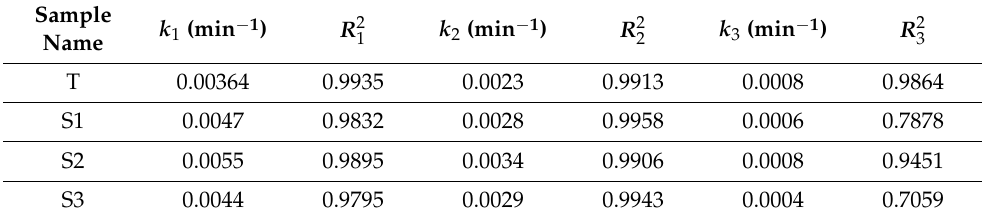
Figure 7. Reaction kinetics of the RhB aqueous solutions in the presence of the T and S1–S3 samples and UV light ( a ). Photocatalytic degradation of RhB solution in the presence of the T and S1–S3 samples ( b ). The reaction rate constant values for each sample ( 𝑘 (cid:2869) , 𝑘 (cid:2870) , and 𝑘 (cid:2871) ) and the corre- sponding linear regression coefficients ( 𝑅 (cid:2869)(cid:2870) , 𝑅 (cid:2870)(cid:2870) , and 𝑅 (cid:2871)(cid:2870) ) are presented in Table 2. Table 2. Reaction kinetics constants of the RhB aqueous solutions in the presence of the T and S1– S3 samples.